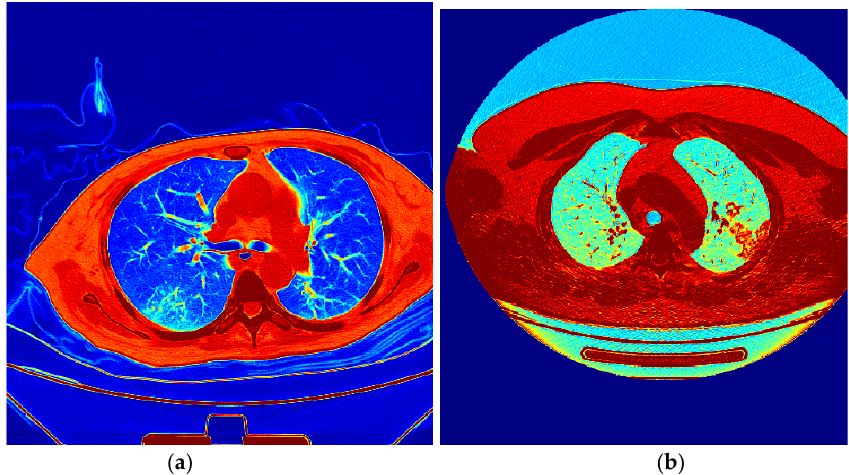
Figure 6. The classification results for ( a ) severe class and ( b ) moderate class meaning that red it’s a very important region and blue less important one used by the classifier.